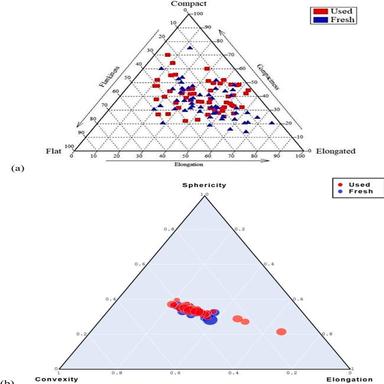
Visual comparison of the fresh and used ballast distribution in the triangular map diagram: (a) funkiness-elongation-compactness; (b) convexityelongation-sphericity index.